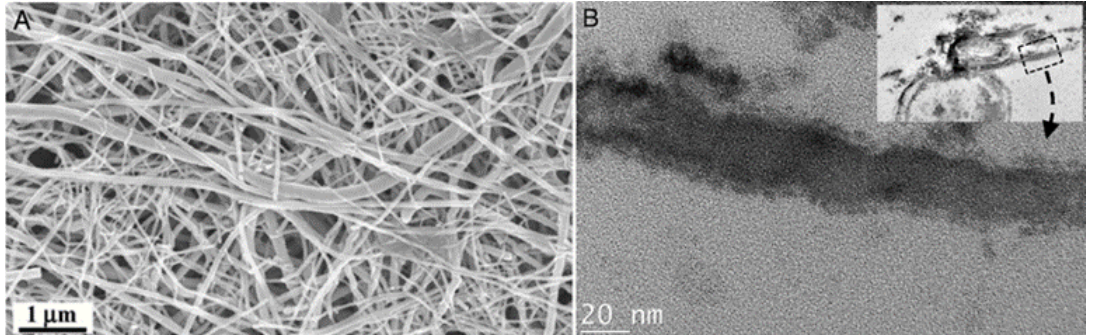
Figure 6. Electron micrographs of biogenic As-S nanotubes produced using the dissimilatory metal-reducing bacterium Shewanella sp. HN-41 once challenged by sources of arsenic and sulfur. ( A ) SEM image; ( B ) laterally sectioned TEM images. Scale bars from left to right are 1 µm and 20 nm. Adapted from Reference [115]. Copyright (2007) National Academy of Sciences.